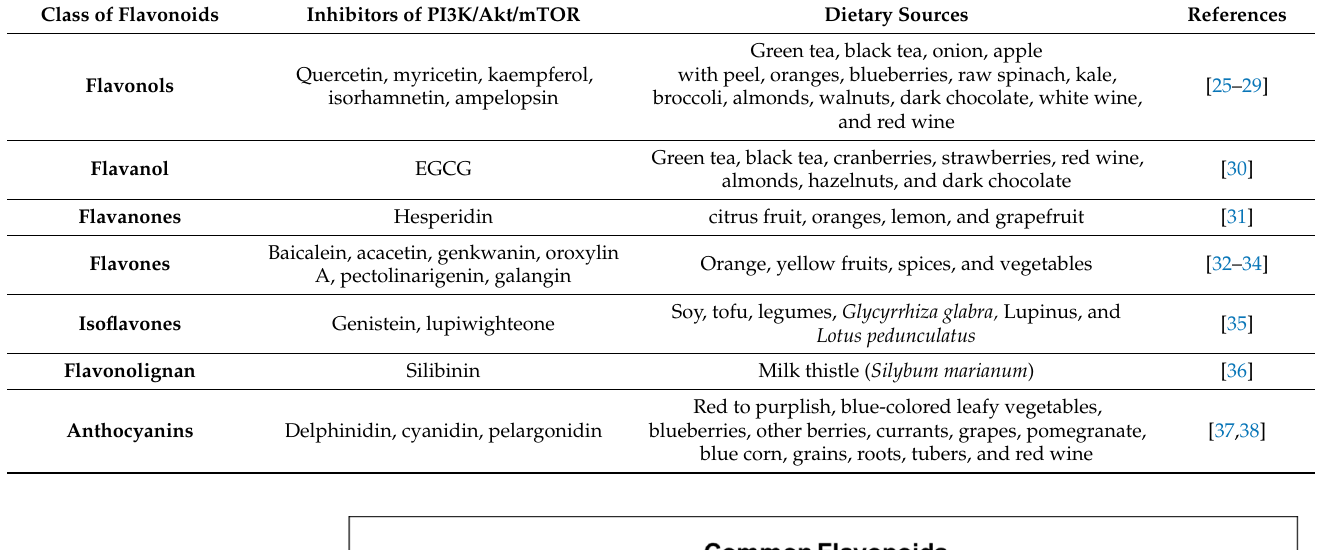
Table 1. Major dietary sources of different flavonoids inhibiting PI3K/Akt/mTOR pathway.